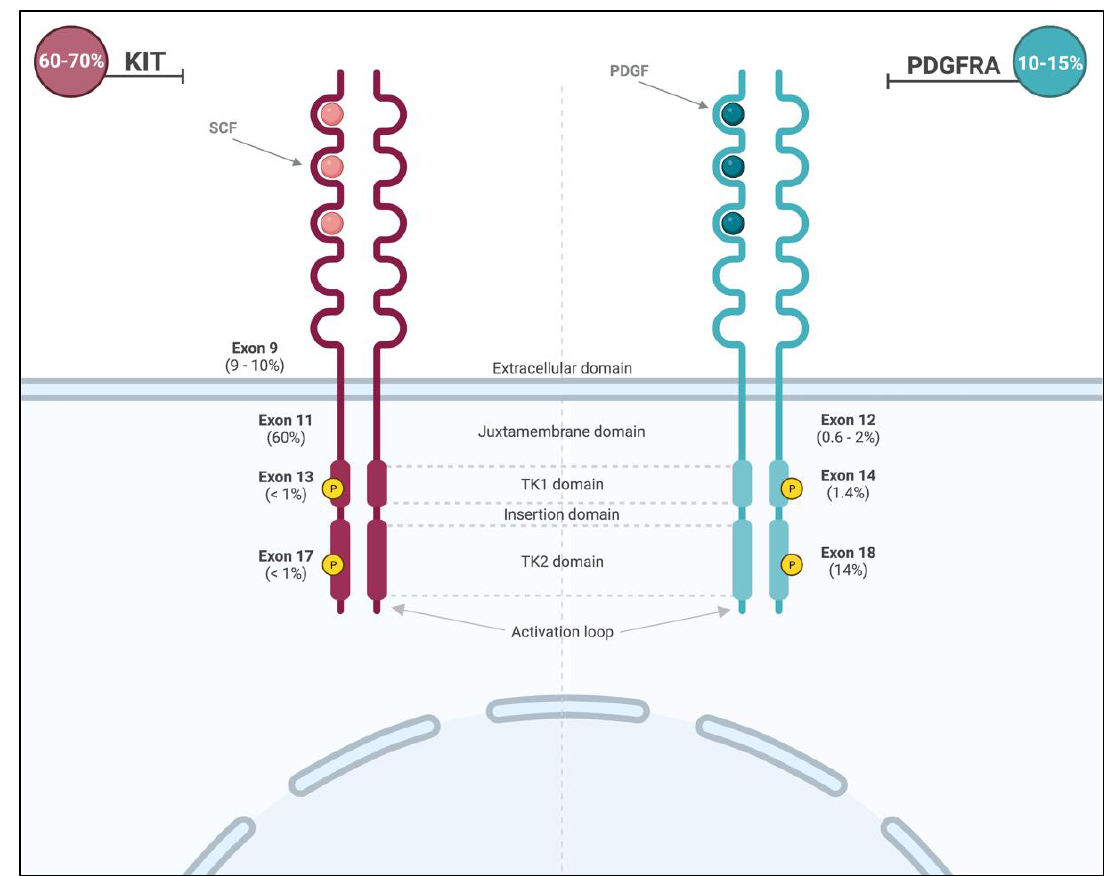
Figure 2. Location and frequencies of most common KIT and PDGFRA mutations.